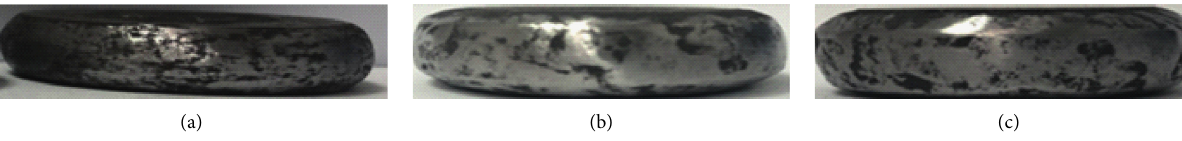
Figure 10: Rupture phenomenon after the upsetting tests at 1373K and the stroking speed of 5mm/s for the critical height reduction ratios of (a) 65.7% (CUP-20), (b) 52.3% (TUP-30), and (c) 51.4%